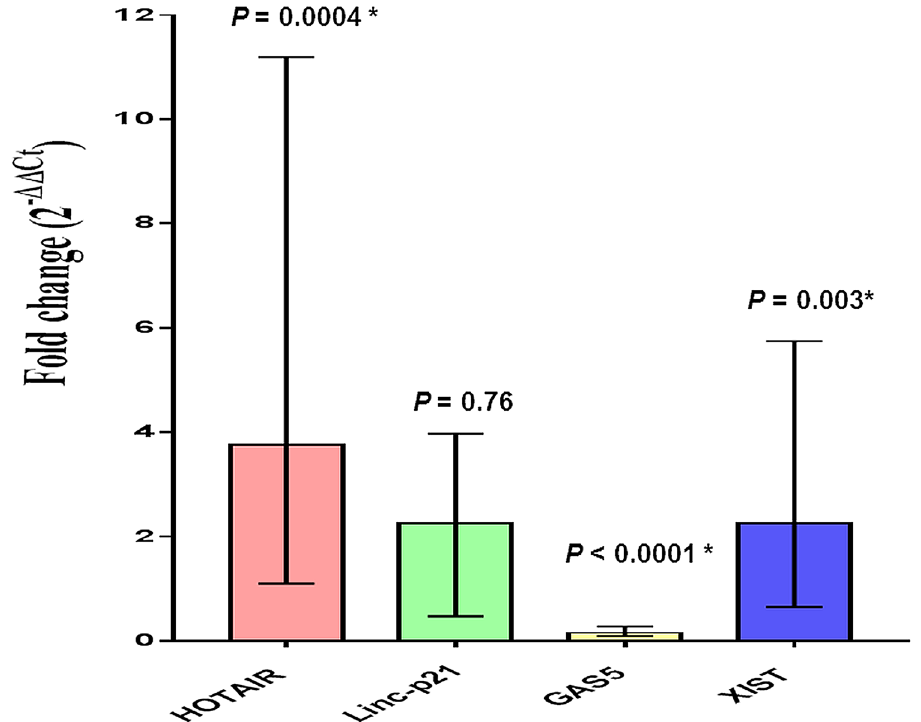
Figure 2. Plasma fold change levels of studied lncRNAs in DLBCL patients compared to healthy controls. Data are presented by median interquartile range. DLBCL, n = 84, controls, n = 33. *Indicates statistical significance ( P <